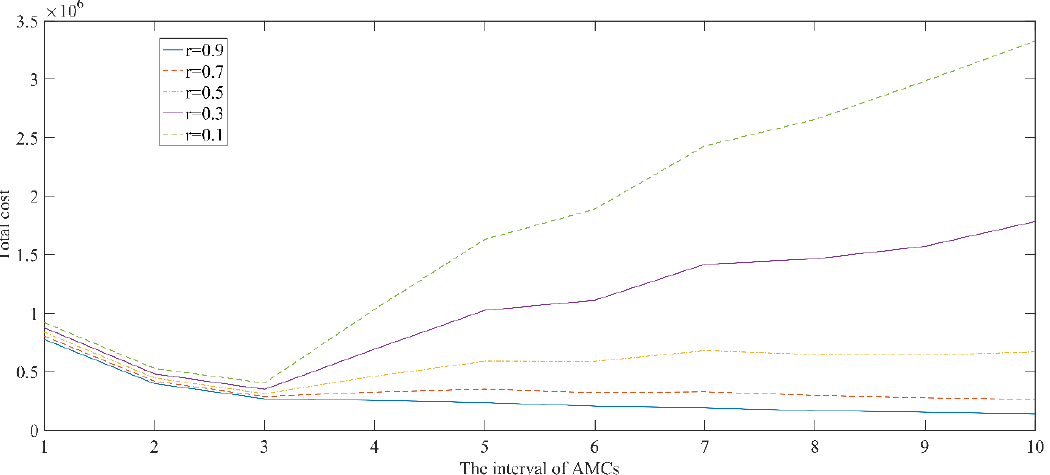
Figure 5. Expected total cost C vs. A for M m = 10 6 , M C A 2 = 0.04, C P = 7, as well as for different values of r .